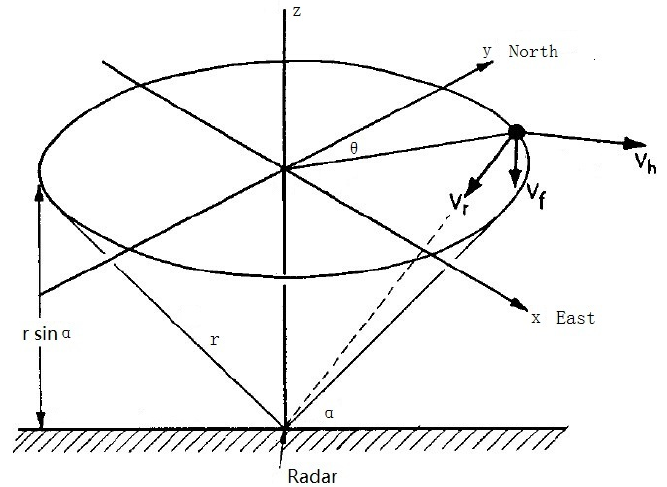
Figure 2. A schematic diagram illustrating VAD